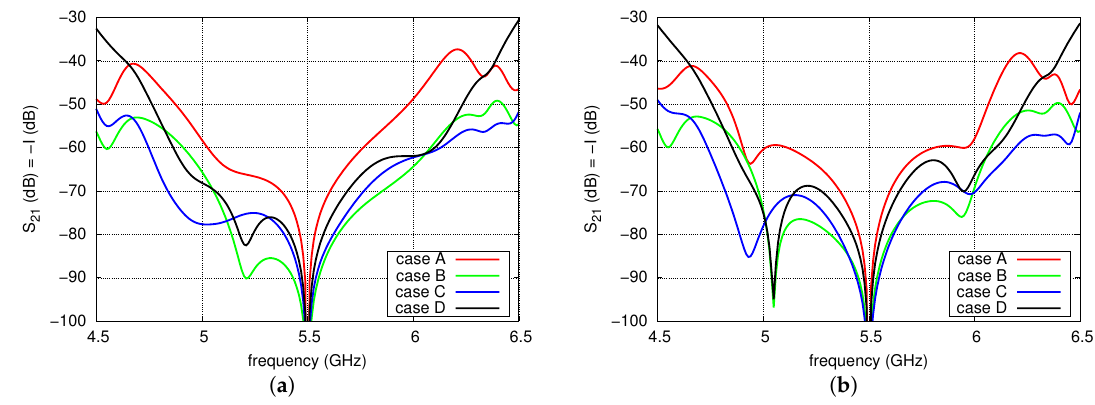
Figure 11. Isolation versus frequency for: ( a ) d = 45 mm; ( b ) d = 50